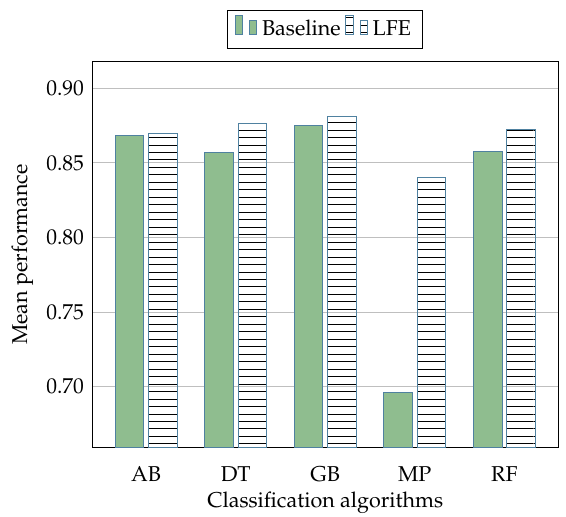
Figure 11. NSL-KDD dataset—overall mean performance in relation to all events.